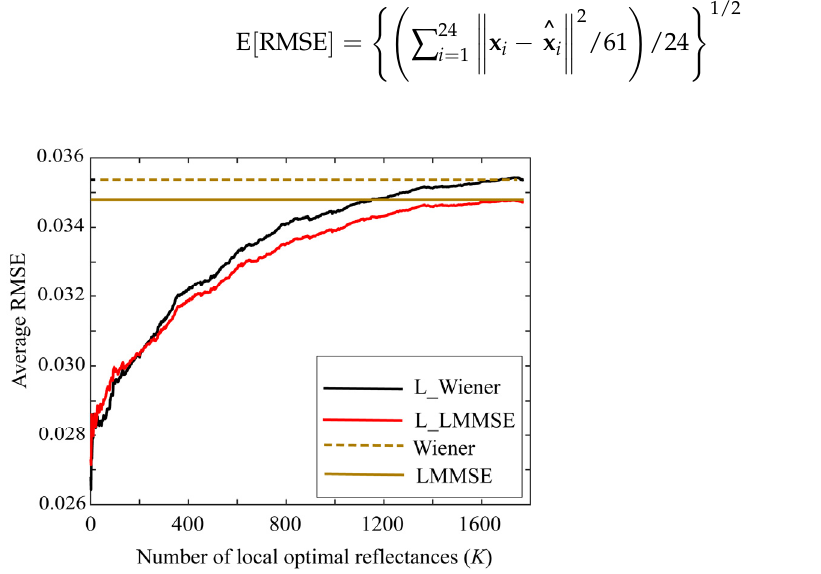
Figure 6. Average RMSEs of the proposed Wiener and LMMSE methods for 24 color checkers as a function of number K of local optimal reflectances when the methods are applied to the image data using Apple iPhone 6s.